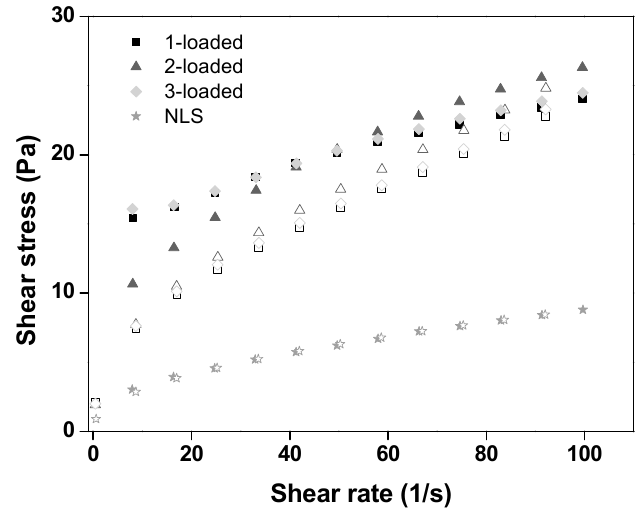
Figure 1. Flow rheograms of NLS, 1-, 2-and 3-loaded into the NLS at 37 ± 0.5 °C. Closed symbol is the going curve and open symbol is the back curve. The standard deviations have been omitted for clarity; however, the coefficients of variation of the triplicate analyses were less than 10% for all formulations. Table 3. Flow index ( η ) and consistency (K) of NLS, 1-, 2-, and 3-loaded into the NLS .